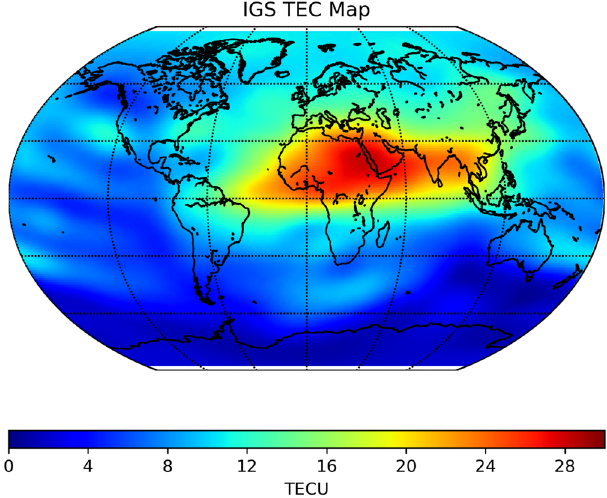
Fig. 4. TEC map for June 5th at 1230 from AENeAS.